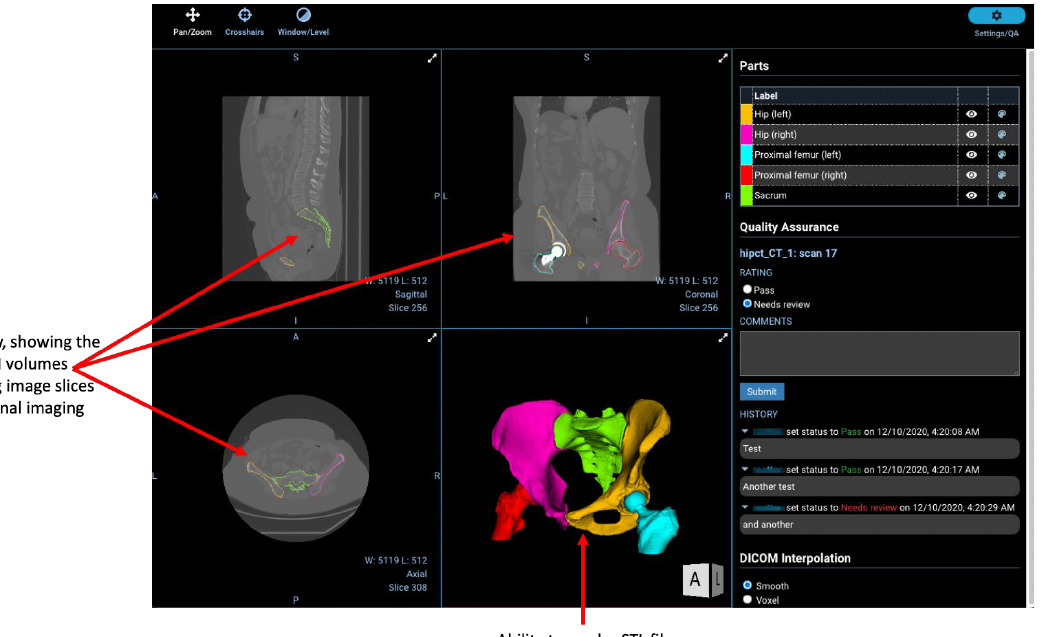
Figure 5. Custom “four-up” view created by Radiologics Inc., demonstrating the visualisation of surface mesh files alongside contour-based ROIs. Currently available only commercially via Flywheel.